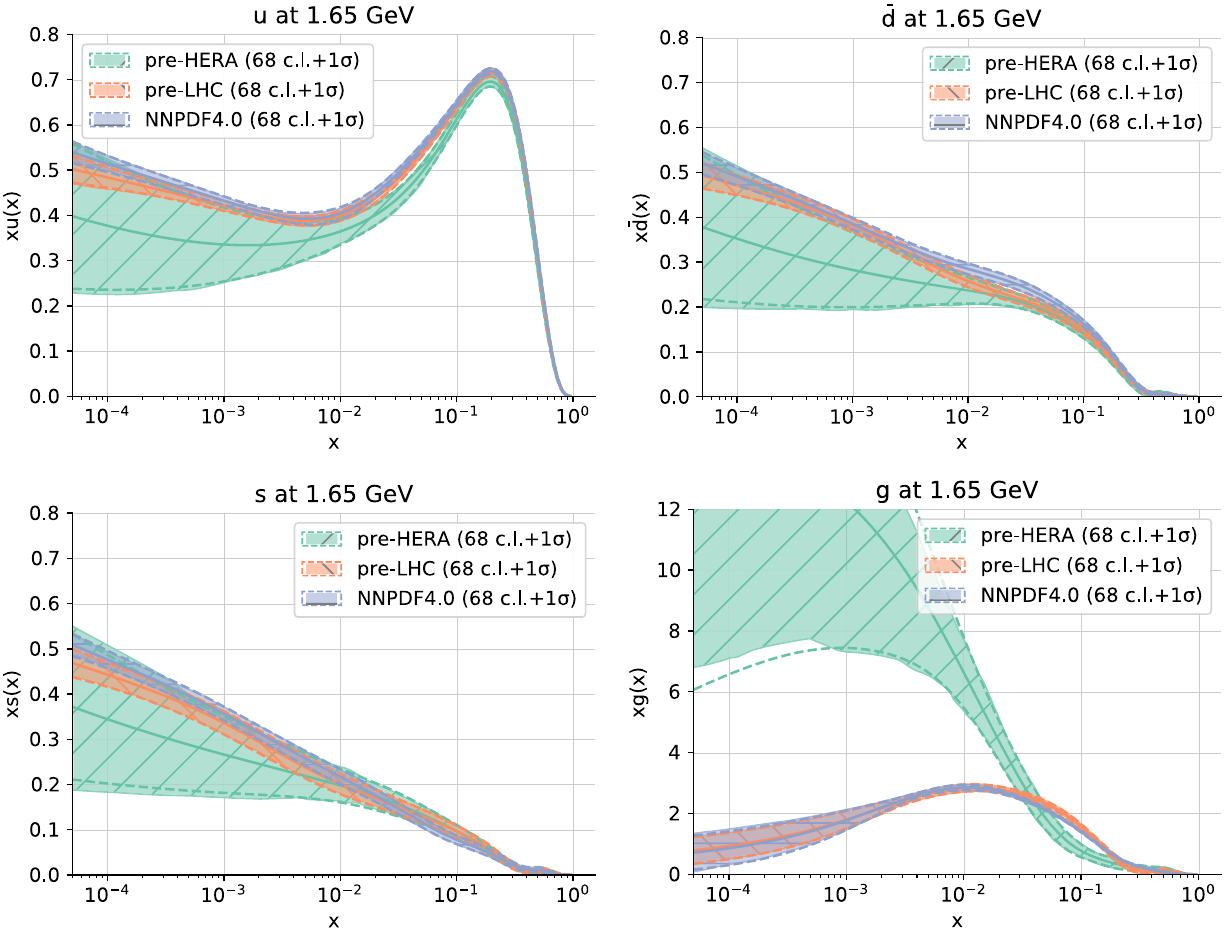
Fig. 29 Same as Fig. 28, but now showing PDFs determined using the NNPDF4.0